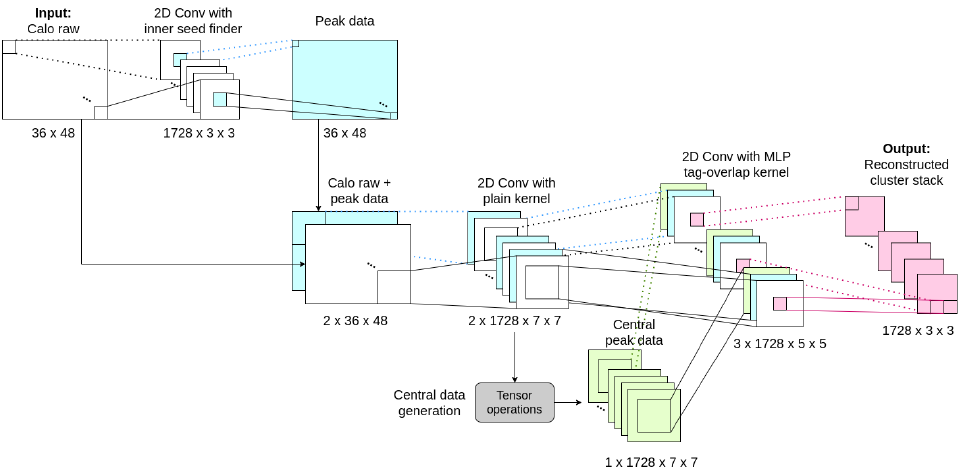
Figure 5. Detailed scheme of the proposed reconstruction dataflow for the inner calorimeter